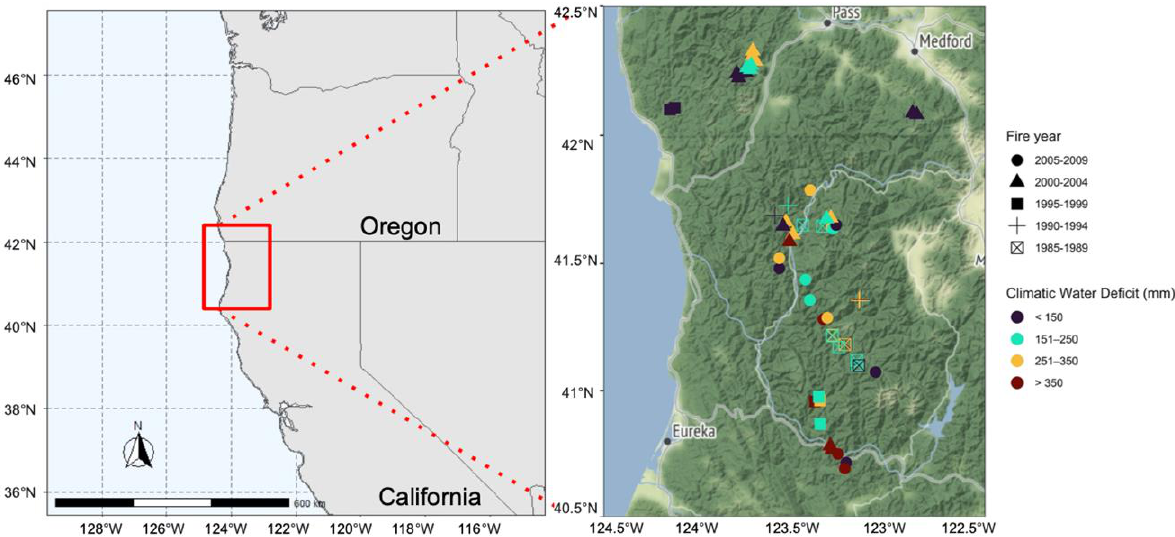
Figure 2. Sample plot locations, with points coded by their climatic water deficit and fire year bin. The geographic area shown in the second figure corresponds to the red rectangle in the first